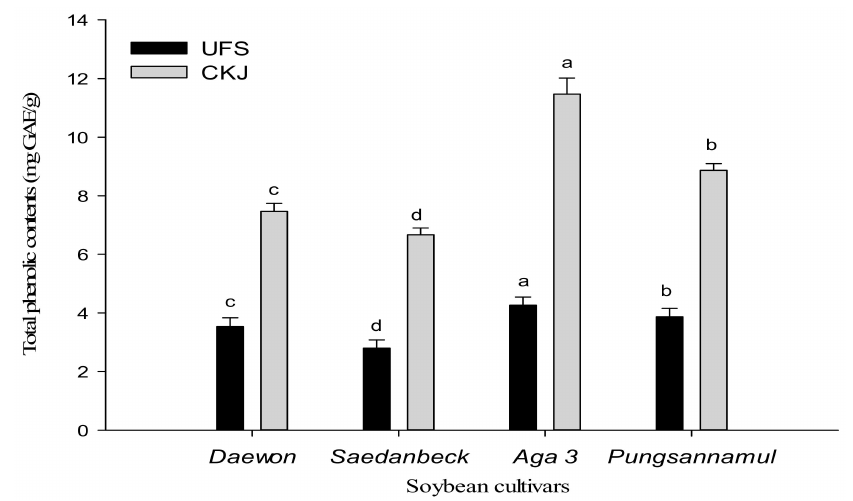
Figure 4. Changes in total phenolic contents (TPC) between UFS and CKJ fermented by Bacillus subtilis (KCTC 13241) in different soybean cultivars. All values are means of three independent experiments. Means with different lowercase letters (a, b, c, and d) represent significant differences among cultivars by Duncan’s multiple range tests (DMRT) ( p <